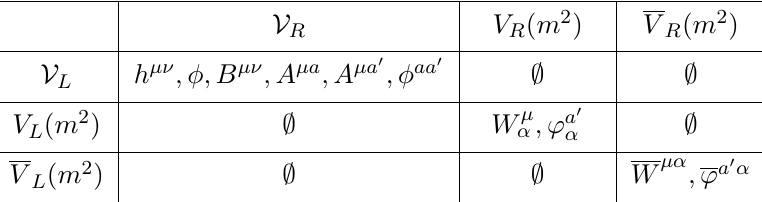
Table 3 . The spectrum of the double-copy of = 4 ; 2 YMESG theories are similar. Here a; (cid:11) are G k indices and a 0 is an R -symmetry index. N